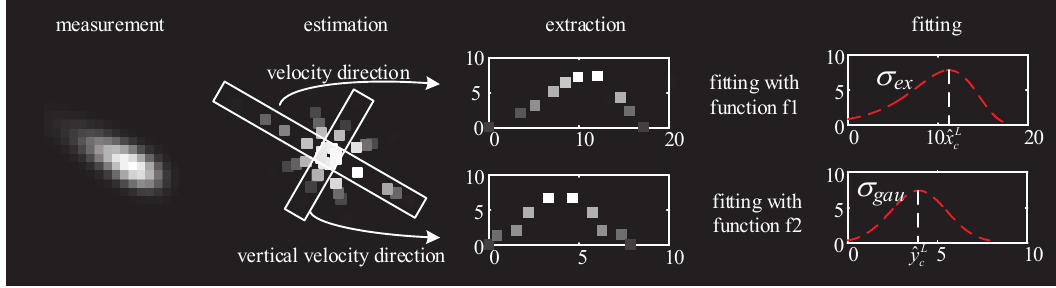
Figure 3. Flow chart of feature